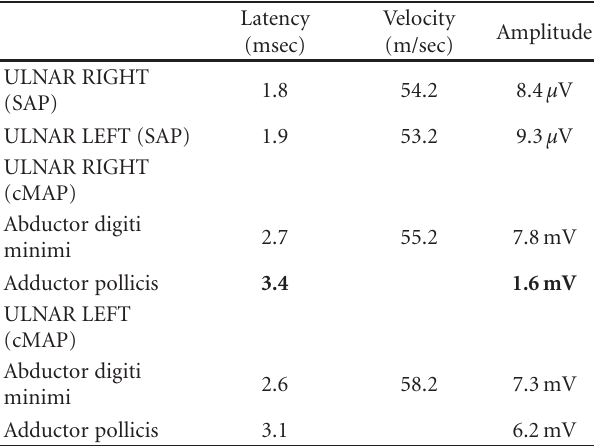
Table 1: Preoperative EMG/NCS of the patient showed selective dysfunction of the right adductor